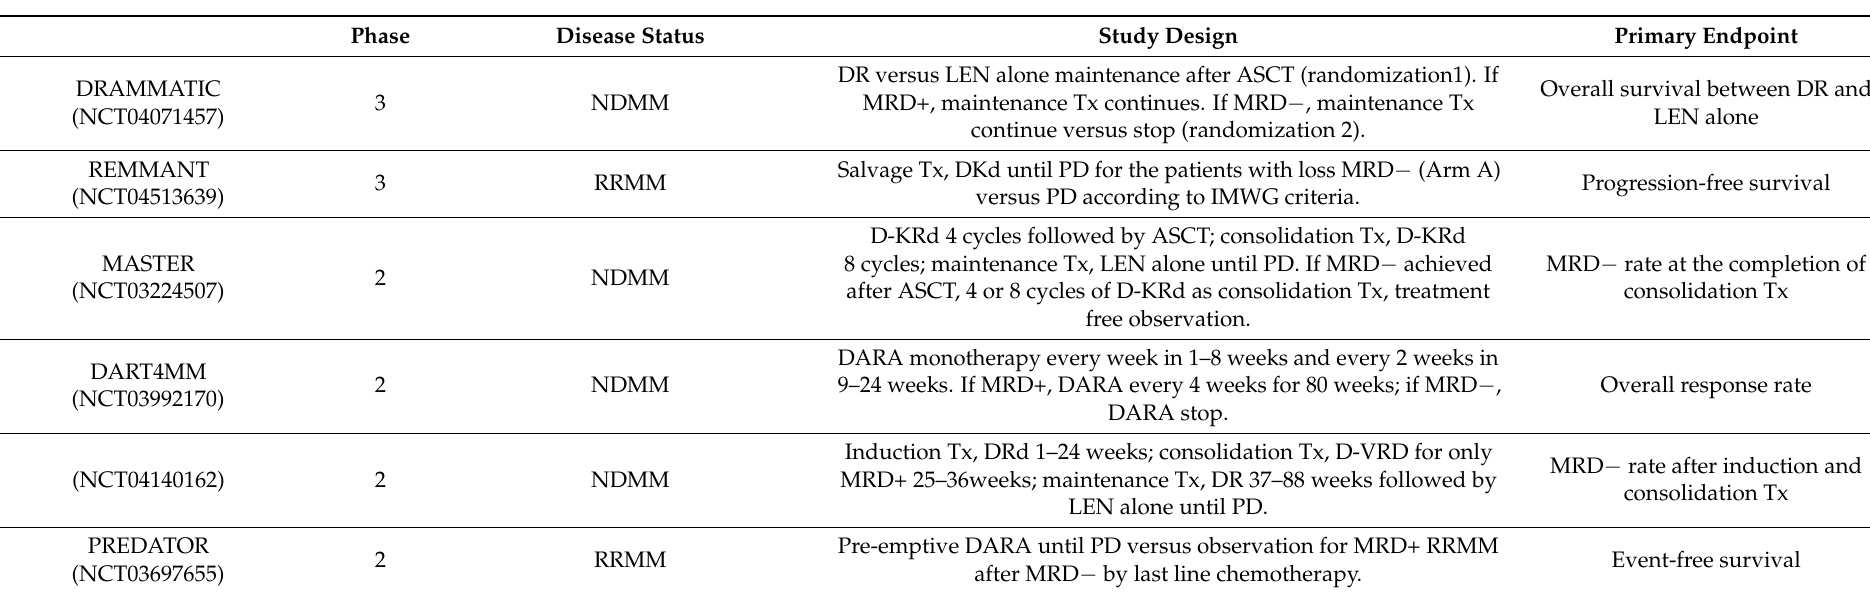
Table 3. Clinical trials concerning MRD status adapted treatment strategies. NDMM, newly diagnosed multiple myeloma; RRMM, relapsed or refractory multiple myeloma; MRD, minimal residual disease; PD, progressive disease; Tx, treatment; DARA, daratumumab; LEN, lenalidomide; K, carfilzomib (CFZ); V, bortezomib (BOR); d, dexamethasone (DEX); ASCT, autologous stem cell transplantation; DR, DARA, plus LEN; DRd, DARA, LEN, plus DEX; DKd, DARA, CFZ, plus DEX; D-KRd, DARA, CFZ, LEN, plus DEX; D-VRd, DARA, BOR, LEN, plus DEX; and IMWG, international myeloma working